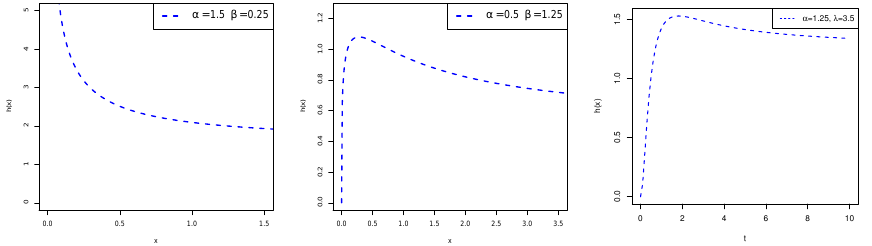
Figure 2. Some possible shapes for the HRF of the EBuH